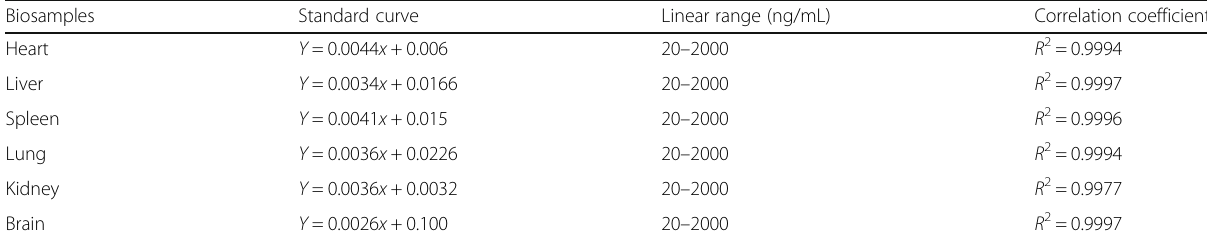
Table 2 Typical equations for the calibration curves Biosamples Standard curve Linear range